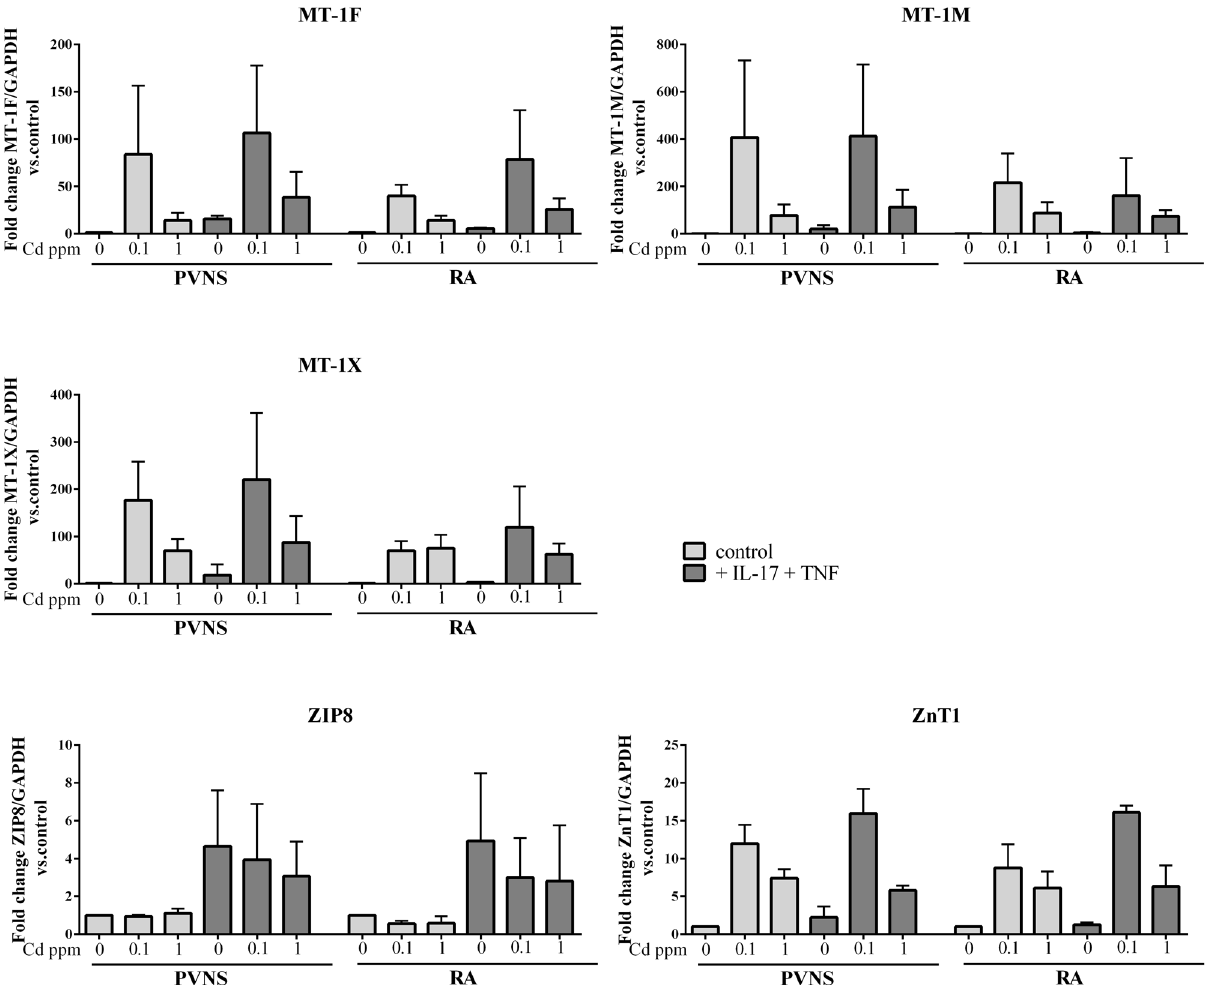
Figure 7. Gene expression of Cd transporters and modulators in PVNS and RA synoviocytes 6 h after Cd exposure. MT-1F, MT-1M, MT-1X, ZIP-8 and ZnT1 mRNA expressions were quantified by quantitative real- time PCR in PVNS and RA synoviocytes treated overnight or not with pro-inflammatory cytokines IL-17 (50 ng/ml) and TNF (1 ng/ml) or in combination and exposed to Cd at 0.1 and 1 ppm. The quantification was done 6 h after Cd exposure. Results are presented as mean ± SD. n = 3 from 3 PVNS patients and 3 RA